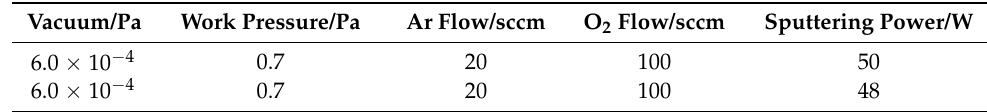
Table 2. Preparation technological parameters of the NiCr/NiSi thin film.